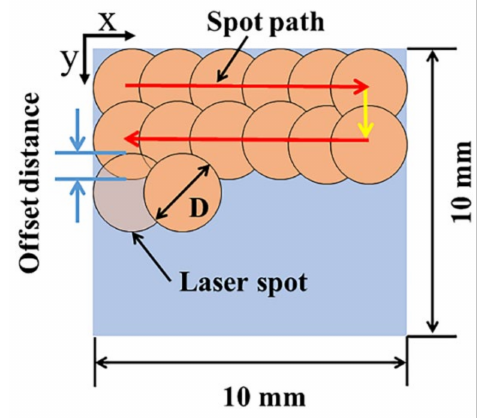
Figure 3. Schematic diagram of laser spot